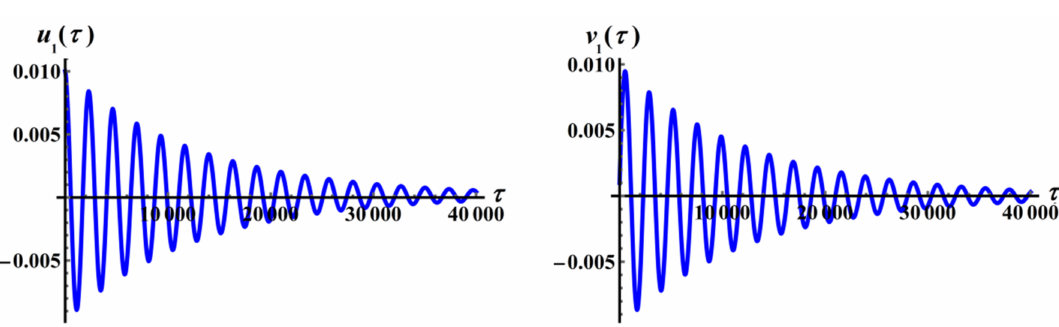
Figure 24. The time histories of u 1 and v 1 .